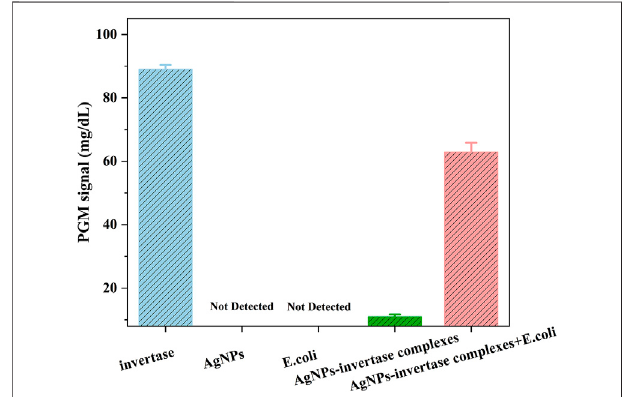
FIGURE 4 | PGM signals under different conditions: invertase, AgNPs, E. coli , AgNPs-invertase complexes, and AgNPs-invertase complexes + E. coli